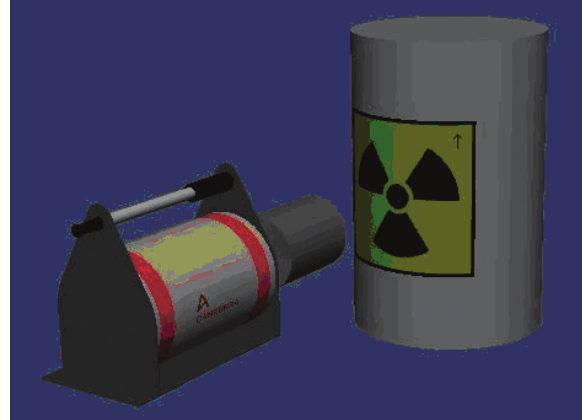
Figure 1. ISOCS measurement geometry Figure 2. Cross-section of the detector’s detection unit model: 1 – aluminum lid with a carbon window; 2 – wire leading channel to detector crystal; 3 – detector crystal; 4 – vacuum